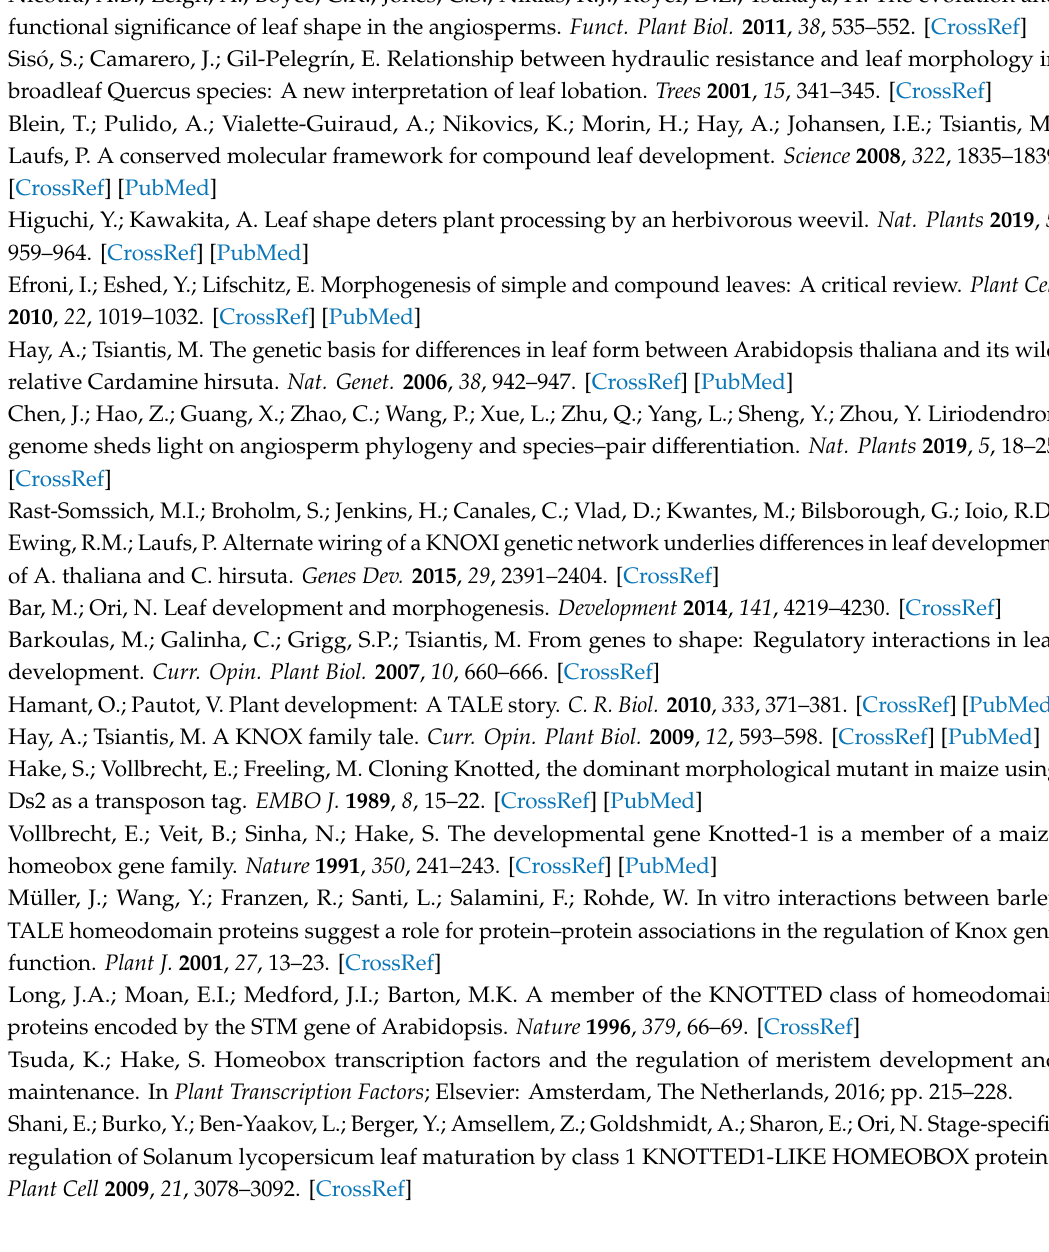
Table S1: The primers of PCR